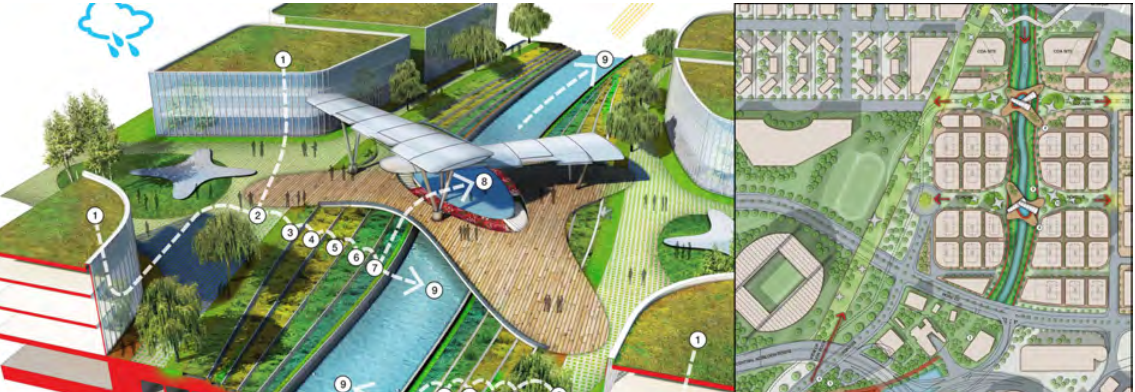
Figure 8. A perspective view and master plan of Upcycle Park, Hong Kong (Source: Architects, 2019).